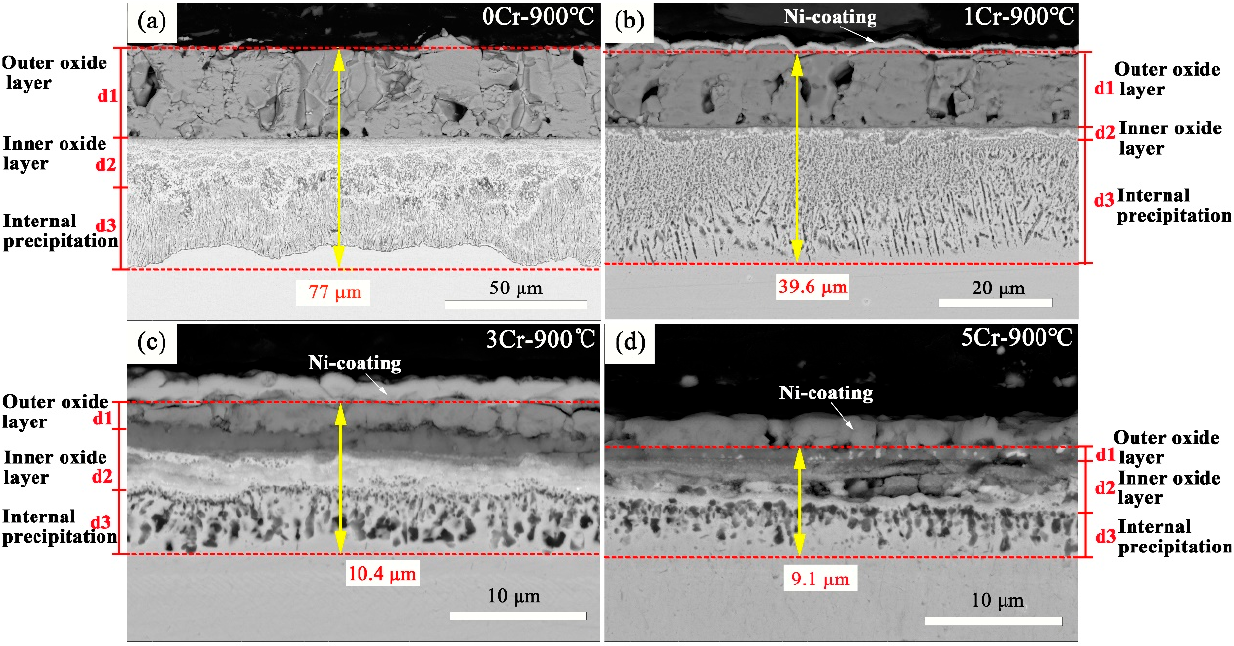
Figure 5. BSE micrographs of multilayered scales on CoNi-based alloys after 100 h exposure at 900 ◦ C in air, ( a ) 0Cr [24]; ( b ) 1Cr; ( c ) 3Cr; ( d ) 5Cr.